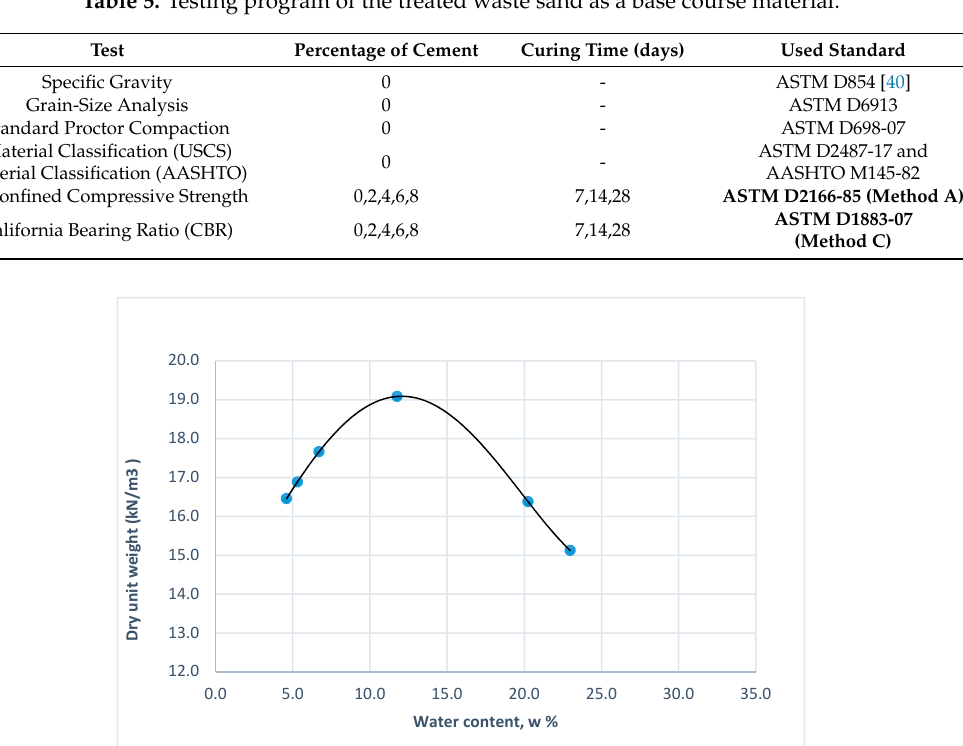
Figure 5. Standard proctor compaction curve of the untreated waste sand (0% cement). Table 5. Testing program of the treated waste sand as a base course material.